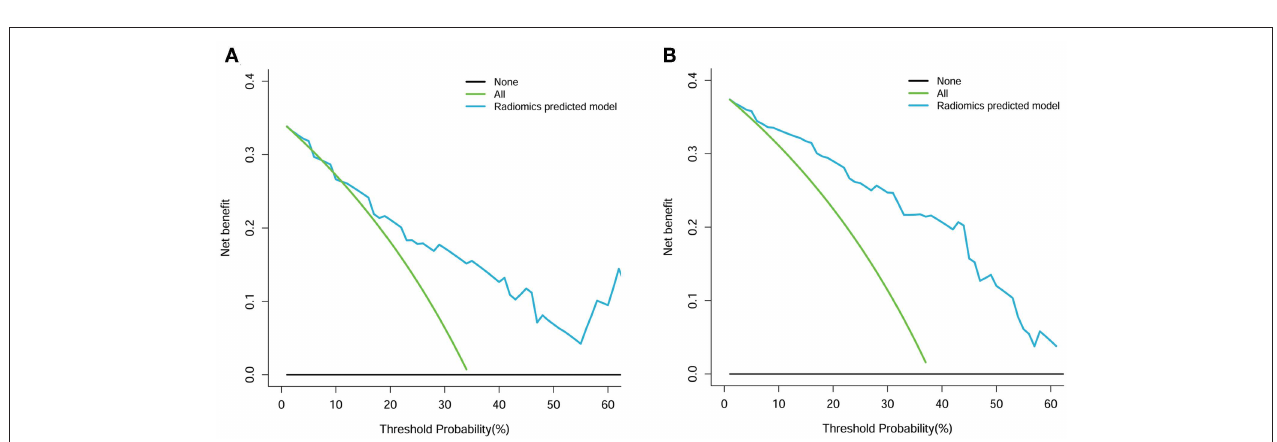
FIGURE 7 | Decision curve analysis for the radiomics model. (A) Primary cohort. (B) Validation cohort. The Y axis measures the net benefit. The blue line represents the radiomics model. The green line represents the assumption that all patients had a firm tumor. The black line represents the assumption that no patients had a firm